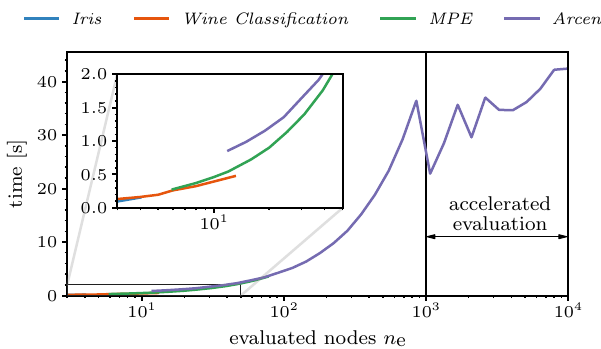
Figure 14. Computation time t for the feature omission impact at different stages in the FeaSel-Net algorithm. The x-axis shows the number of evaluated nodes n e